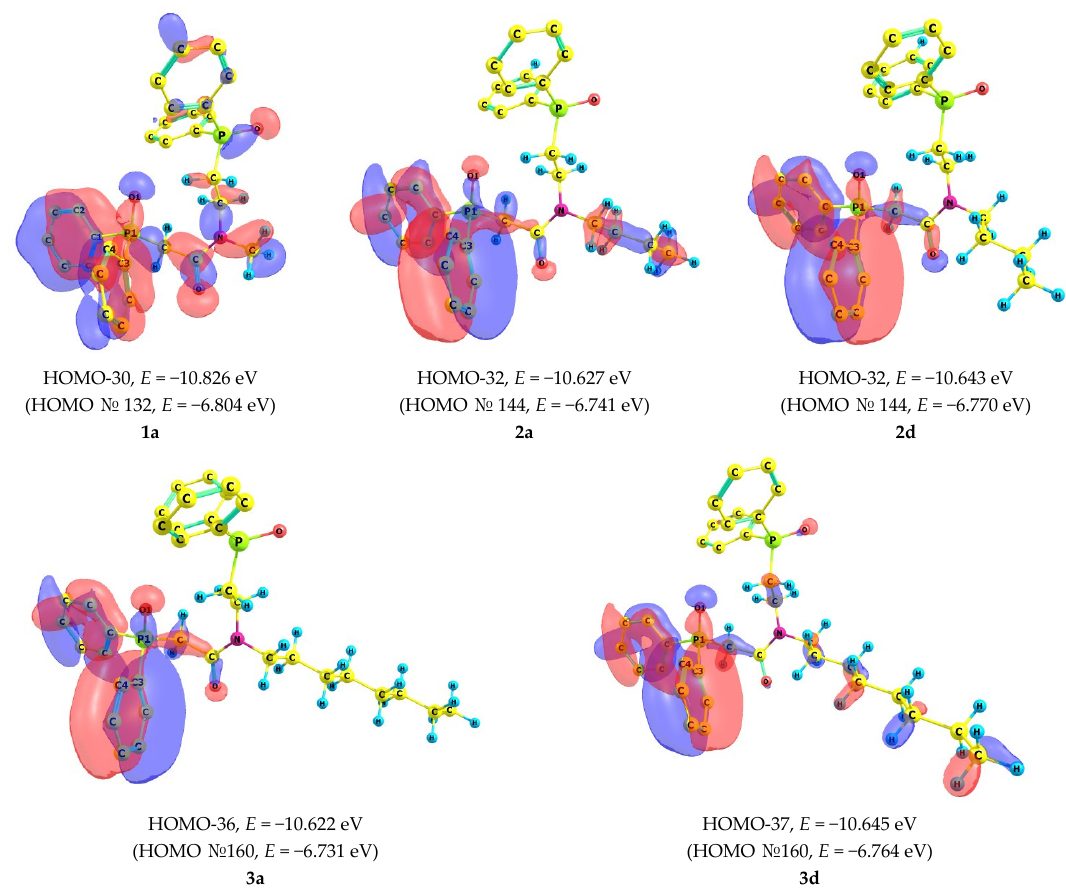
solid state: the 717 cm − 1 band splits in two (715 cm − 1 and 723 cm − 1 ), the 793 cm − 1 band splits in two (790 cm − 1 and 795 cm − 1 ), and new bands at 740 cm − 1 and 774 cm − 1 appear. The IR spectra of 3 also contain three vibrational bands in the melt and six bands in the solid state. New bands at 760 cm − 1 , 777 cm − 1 , and 809 cm − 1 appear. These IR spectral data indi- cate the presence of conformational equilibrium in acetamides 1 ‒ 3 . Figure 4. Visualization of the molecular orbitals № 102 for 1a , № 112 for 2a , № 112 for 2d , № 124 for 3a , and № 123 for 3d corresponding to the interaction of the P=O bond and phenyl substituents. The positive and negative wave functions are shown as blue and red areas, respectively. The isocontour value is 0.02 a.u. The frontier orbitals are not given, since we do not consider the reactivity of the compounds in this context.